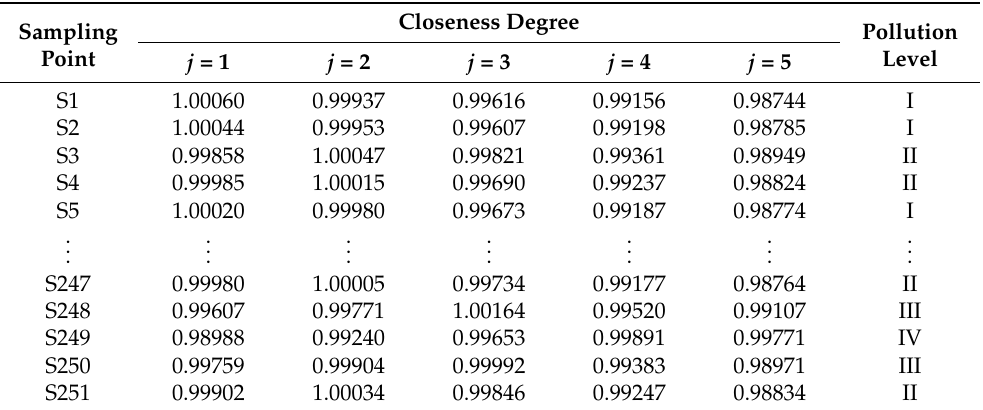
Table 5. Degree of closeness between the matter–elements to be evaluated and the pollution levels of potential toxic elements in